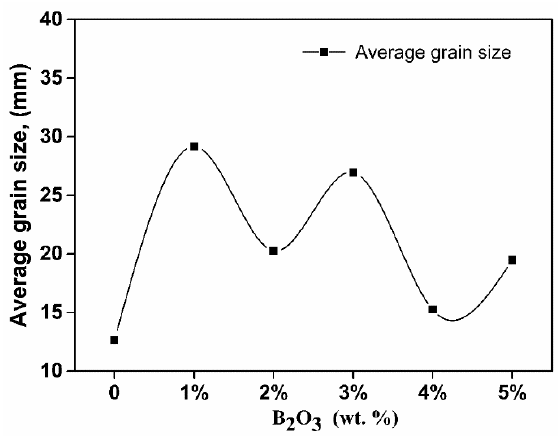
Figure 4. The average grain size of sinter with B 2 O 3 addition.